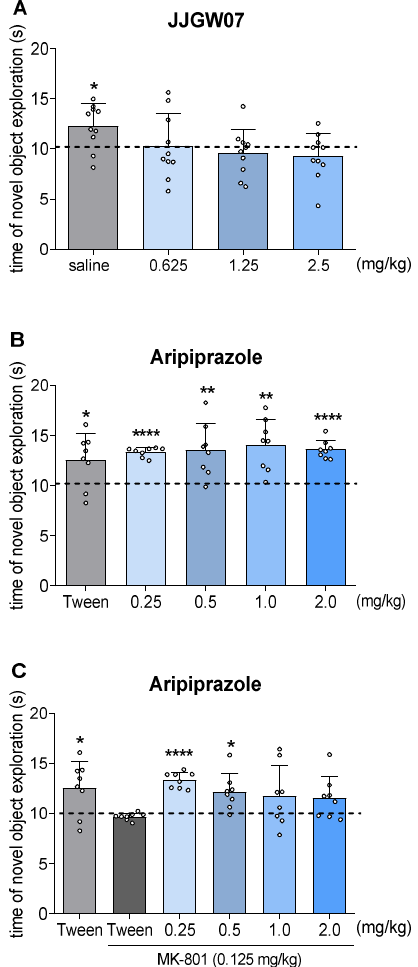
Figure 6. The influence of JJGW07 (Panel ( A )) and aripiprazole (Panel ( B )) on the novel object exploration time in mice as well as the influence of aripiprazole (Panel ( C )) on the novel object exploration time after the MK-801 administration in mice. The experiment consisted of two sessions. On the first day, mice were placed and left in cages until they reached a total exploration time of 20 s for both identical subjects, but for no longer than 10 min. JJGW07 and aripiprazole were administered intraperitoneally ( ip ) 30 min before the start of the experiment, while MK-801 (0.125 mg/kg) was administered ip 15 min before the start of the experiment to induce the memory impairments. The control group received an ip 0.9% NaCl solution ( A ) or 1% Tween ( B ) as well as two injections of 1% Tween or 1% Tween ( ip ) and MK-801 (0.125 mg/kg; ip ) ( C ). On the second day, mice were placed again in cages, where one subject was changed to a new one. The mice remained in the cage until they reached a total exploration time of 20 s for both objects, but for no longer than 10 min. Values are expressed as means ± SD; n = 8–10 mice per group. Statistical analysis: one-sample t -test; * p < 0.05, ** p < 0.01, **** p < 0.0001 vs. chance level = 10